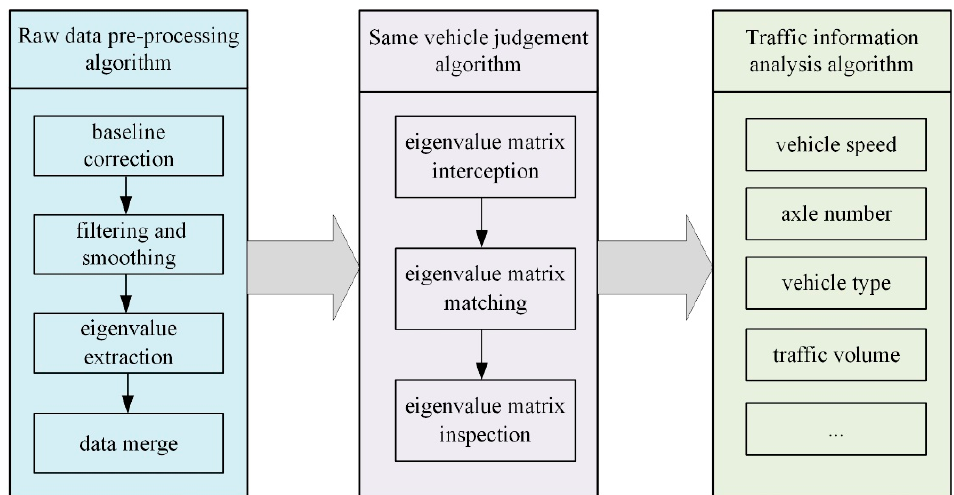
Figure 10. Data processing algorithms in remote server.